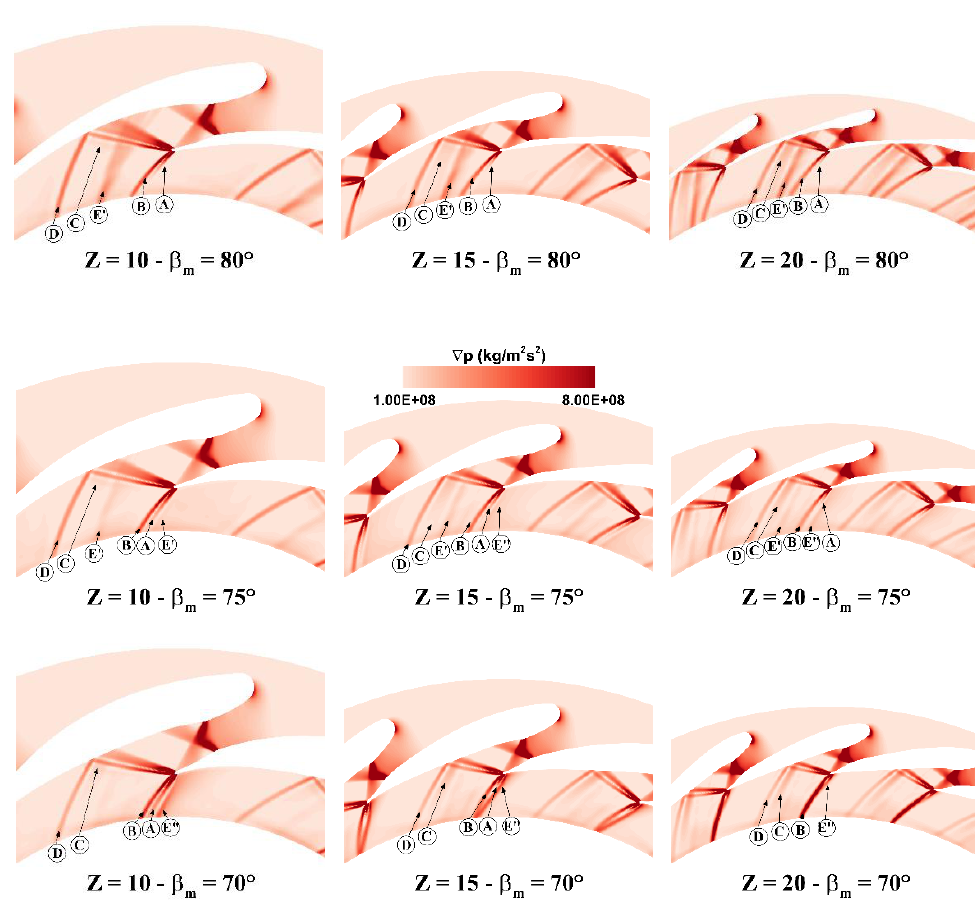
Figure 7. Pressure gradient contours.